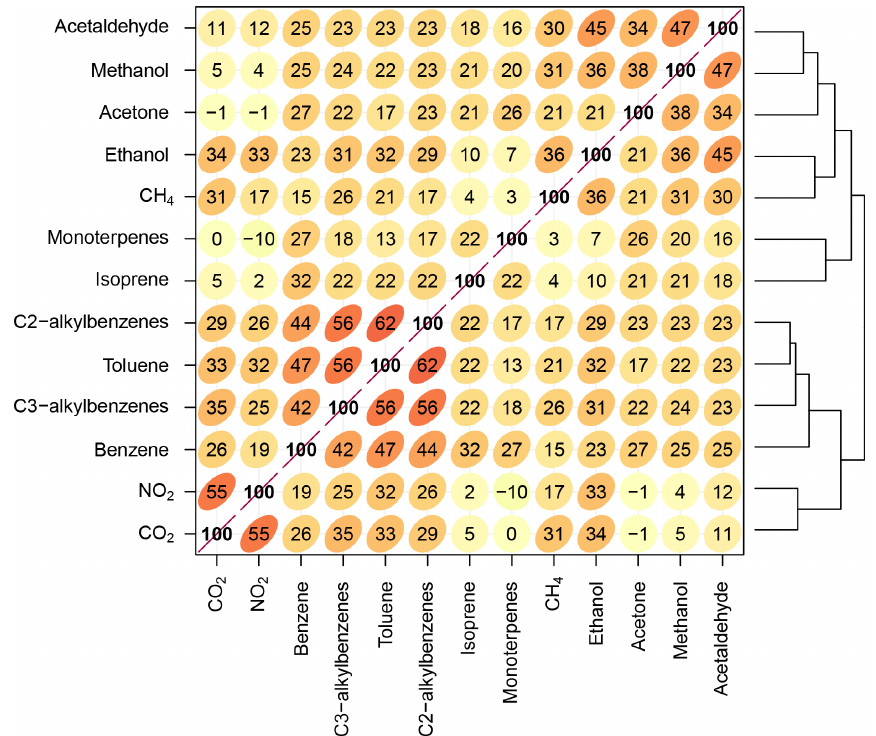
Figure 8. Spearman correlation of the compounds measured using the WASP and the SIFT-MS during measurements in York. Note that hierarchical clustering is applied to the correlation matrices to group species that are most similar to one another. A higher correlation coefficient between species is represented by a higher number, a darker red colour and an ellipse (shape). The lines on the right-hand side show the hierarchical clustering between compounds and represent clusters of species with similar patterns and/or